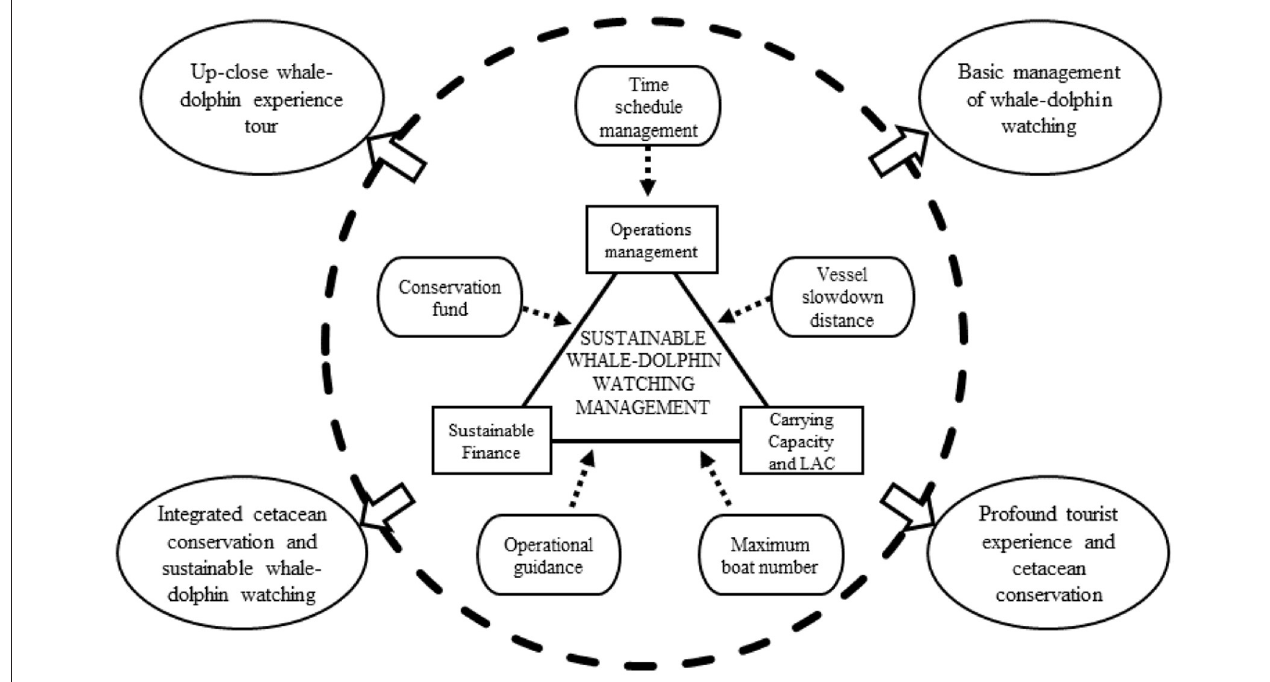
FIGURE 4 | Conceptual framework to establish an impact mitigation program for a sustainable whale-dolphin watching management.